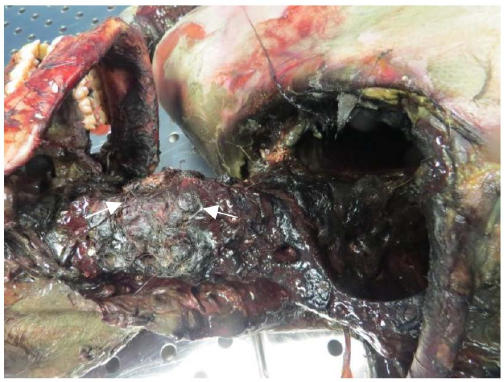
Figure 1. Skeletonized skull and cervical spine tract. Dog hair is noticeable on the neck (white